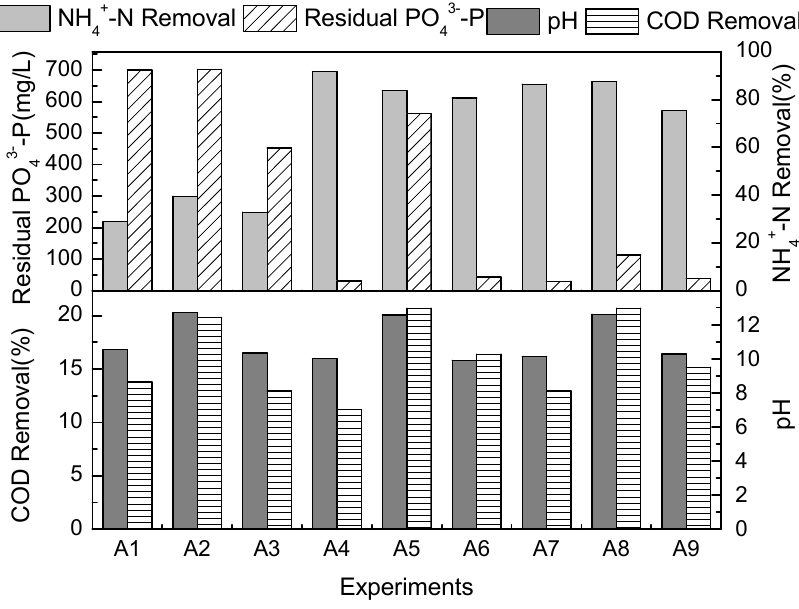
Figure1. NH 4+ -N removal, residual PO 43 − -P, pH and COD removal at a pH of 9, Mg 2+ :NH 4+ -N:PO 43 − -P molar ratio of 1:1:1 and a mixing time 15